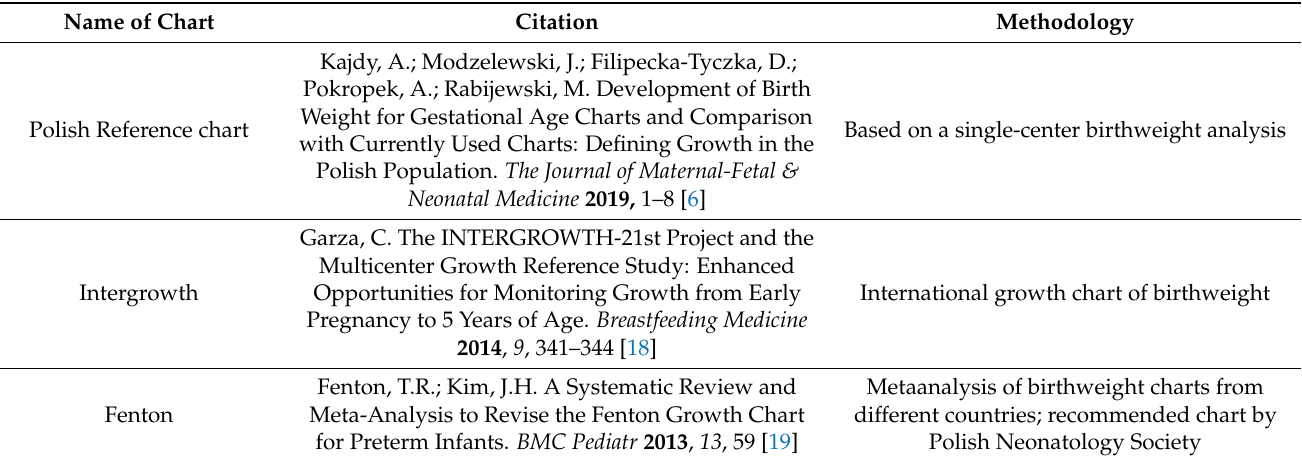
Table 1. The characteristics of birth-weight charts used in the